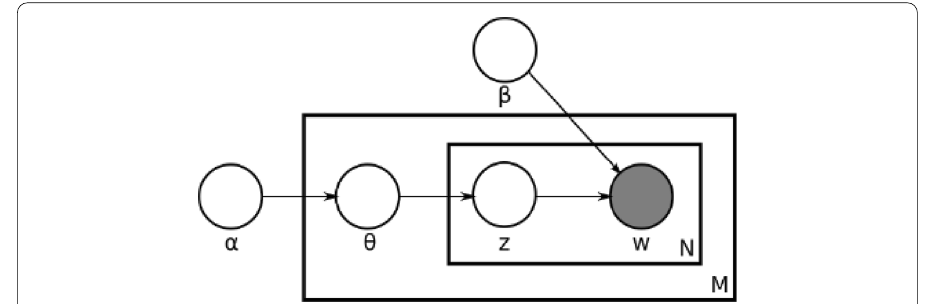
Fig. 2 Latent Dirichlet Allocation (LDA)